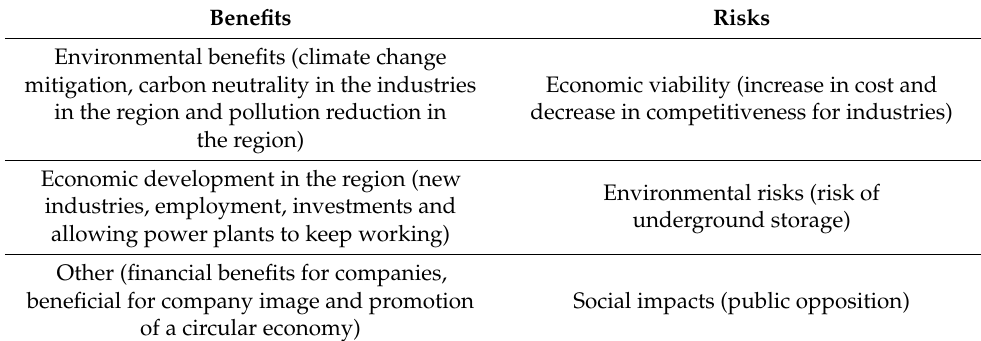
Social impacts (public